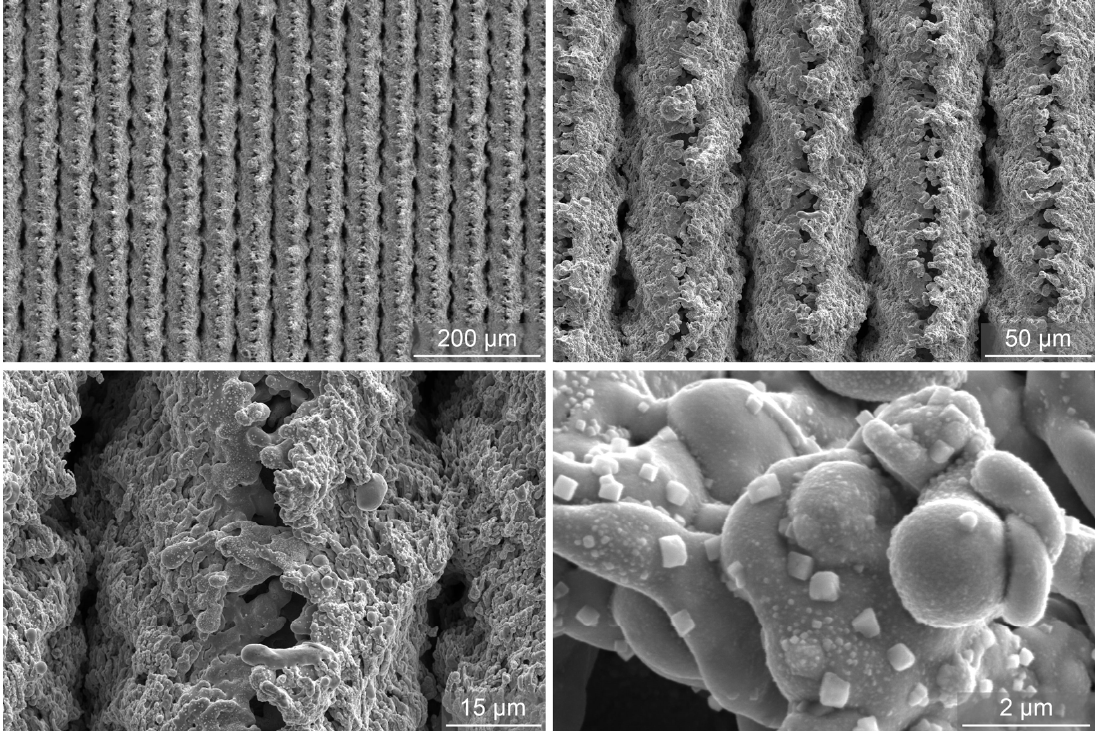
Figure 4. SEM images of the laser-textured sample LT after exposure to the boiling of water